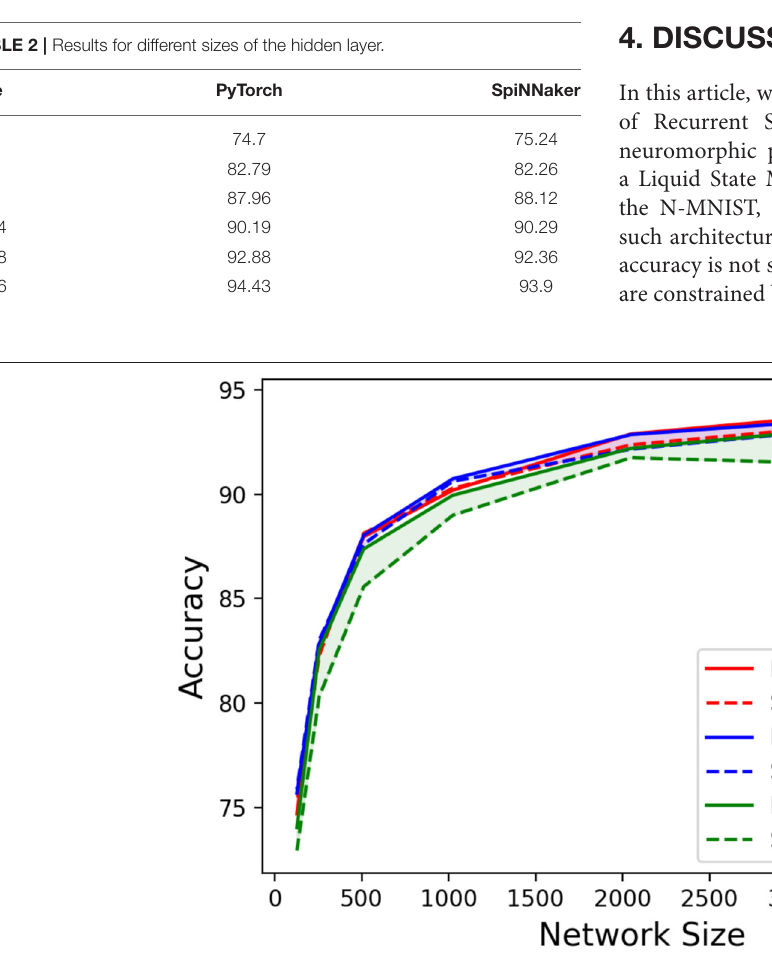
FIGURE 8 | Accuracies per network size (number of neurons in the liquid population) for three different weight precisions implemented in PyTorch and SpiNNaker.